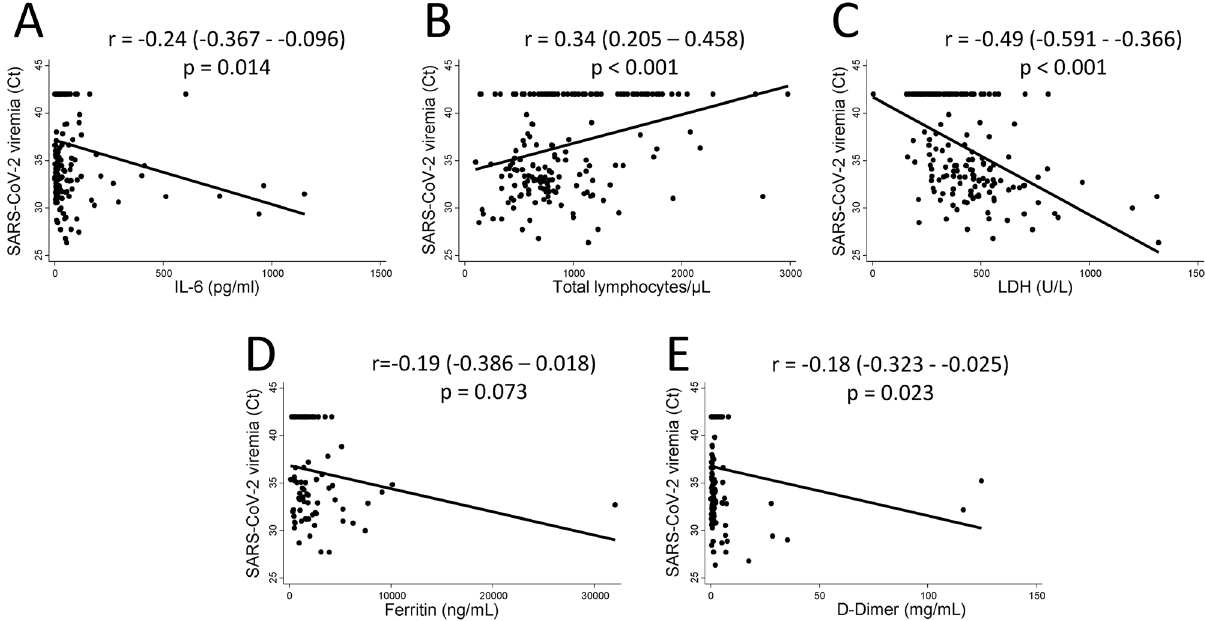
Figure 4. Viremia correlates with the main laboratory prognosis biomarkers described in patients hospitalized with severe COVID-19. Correlation between viremia levels (Ct value by Thermo Fisher Scientific [TFS] technique) and IL-6 levels (pg/mL) ( A ), lymphocytes count (cel/mm 3 ) ( B ), LDH levels (U/L) ( C ), ferritin levels (ng/mL) ( D ), d-Dimer levels (mg/mL) ( E ). Data are shown as dot plots of the corresponding values and the fitted linear prediction (black line) obtained with the option lfit of the command twoway of Stata. Correlation coefficients and significance levels were estimated with the Pearson’s test. Model 1 Model